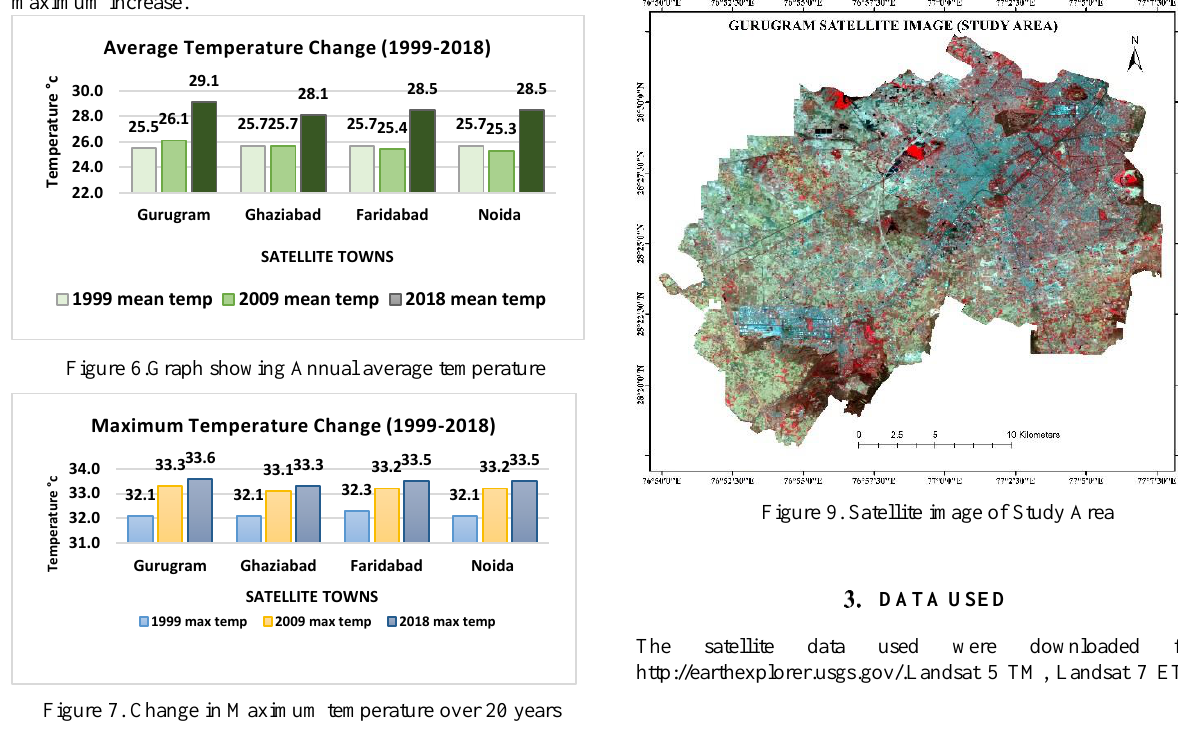
Figure 7. Change in Maximum temperature over 20 years